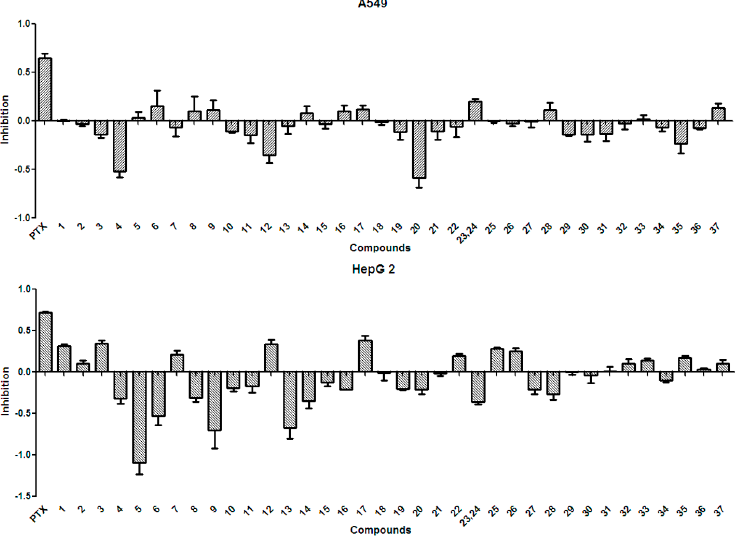
Figure 3. The anti-tumor activity against A549 and HepG2 of the polyphenols ( 1 – 37 ) isolated from X. sorbifolia husks. MTT 3-(4,5-dimethyl-2-thiazolyl)-2,5-diphenyltetrazolium bromide was dissolved in PBS at 5 mg/mL. After the formazans were dissolved in DMSO for 10 min, the absorbance values at 490 nm were measured, and the percentage inhibitions were calculated. PTX, Paclitaxel.